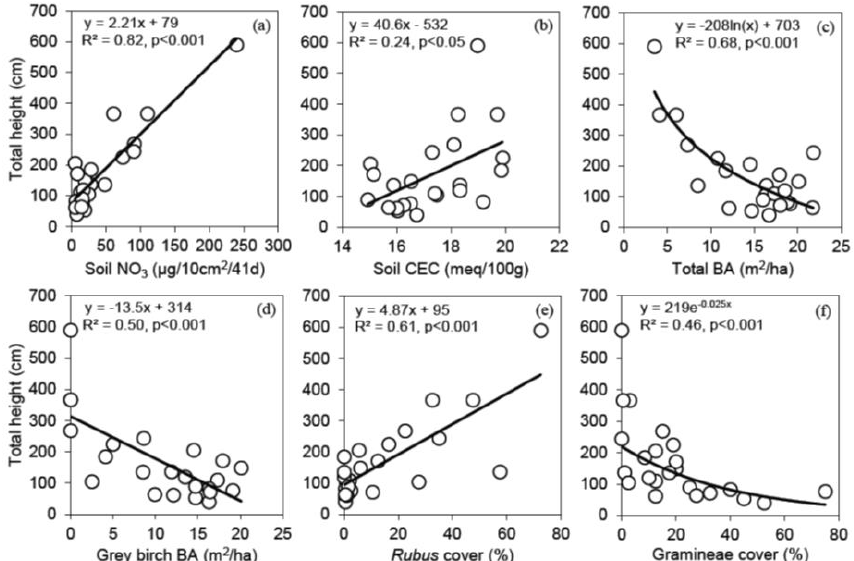
Figure 8. Black walnut ( Juglans nigra ) total height after 6 years as a function of ( a ) soil NO 3 supply rate, ( b ) soil cation exchange capacity (CEC), ( c ) total basal area (BA) of trees in the shelterwood, ( d ) basal area (BA) of grey birch ( Betula populifolia ) in the overstory, ( e ) cover of Rubus species in the understory and ( f ) total cover of grass (Gramineae) species in the understory. N = 23 plots for each relationship.